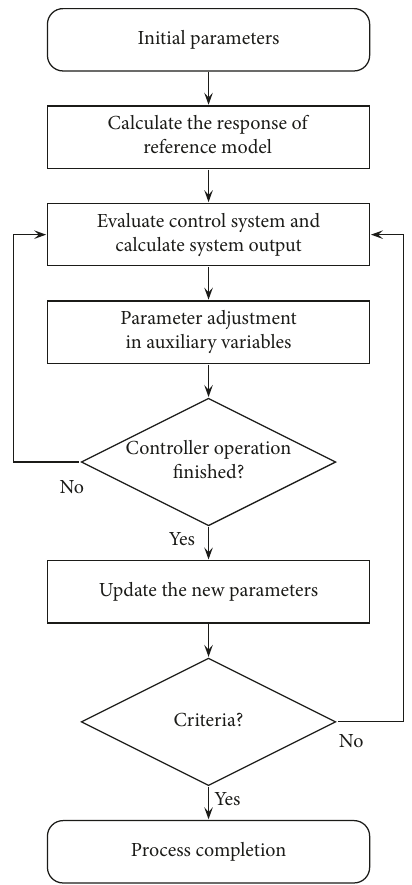
Figure 10: Algorithm for training the neuro-fuzzy controller.